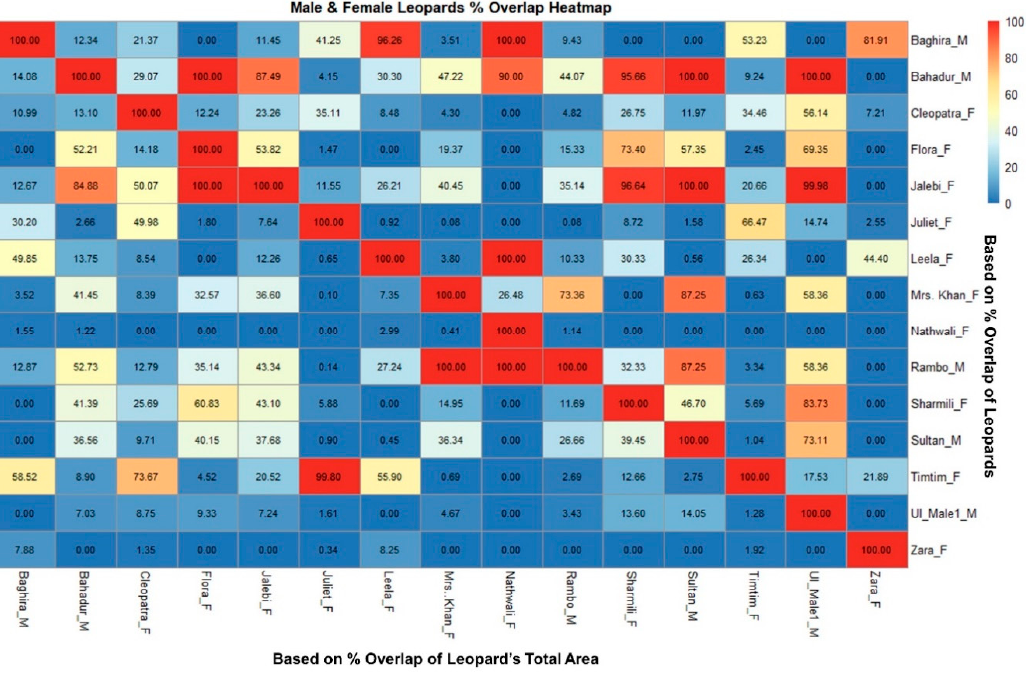
Figure 9. Heatmap matrix showing the percent overlap between the leopards of Jhalana Reserve Forest, India, along the y -axis.